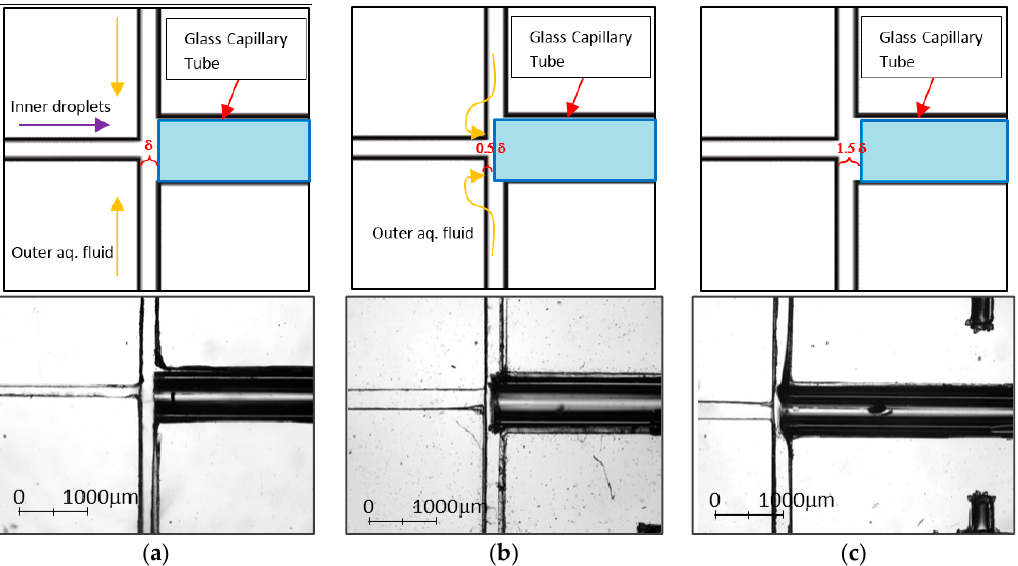
Figure 9. ( a ) Schematic illustration and the microscopic image of the glass capillary tube positioned at δ ; ( b ) schematic illustration and the microscopic image of the glass capillary tube positioned at 0.5 δ ; and ( c ) schematic illustration and the microscopic image of the glass capillary tube positioned at 1.5 δ . The glass capillary tube in the microscopic image dislocated due to expansion after heating. In the schematic diagram, yellow arrows indicate the flow of the outer aqueous phase according to different positions of the glass capillary tube while the purple arrow indicates the flow of the inner droplets.